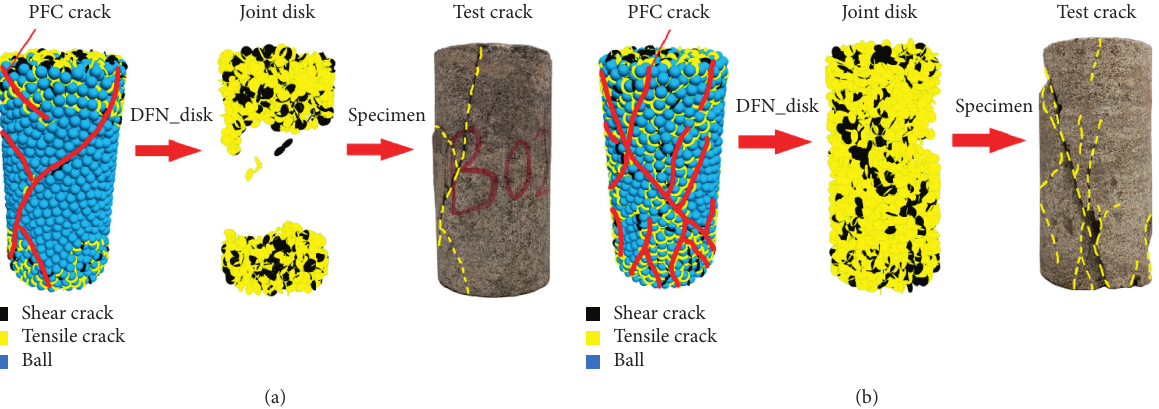
Figure 11: Triaxial failure joints (cracks) of sandstone under different confining pressures. (a) Confining pressure of 2MPa. (b) Confining pressure of 8